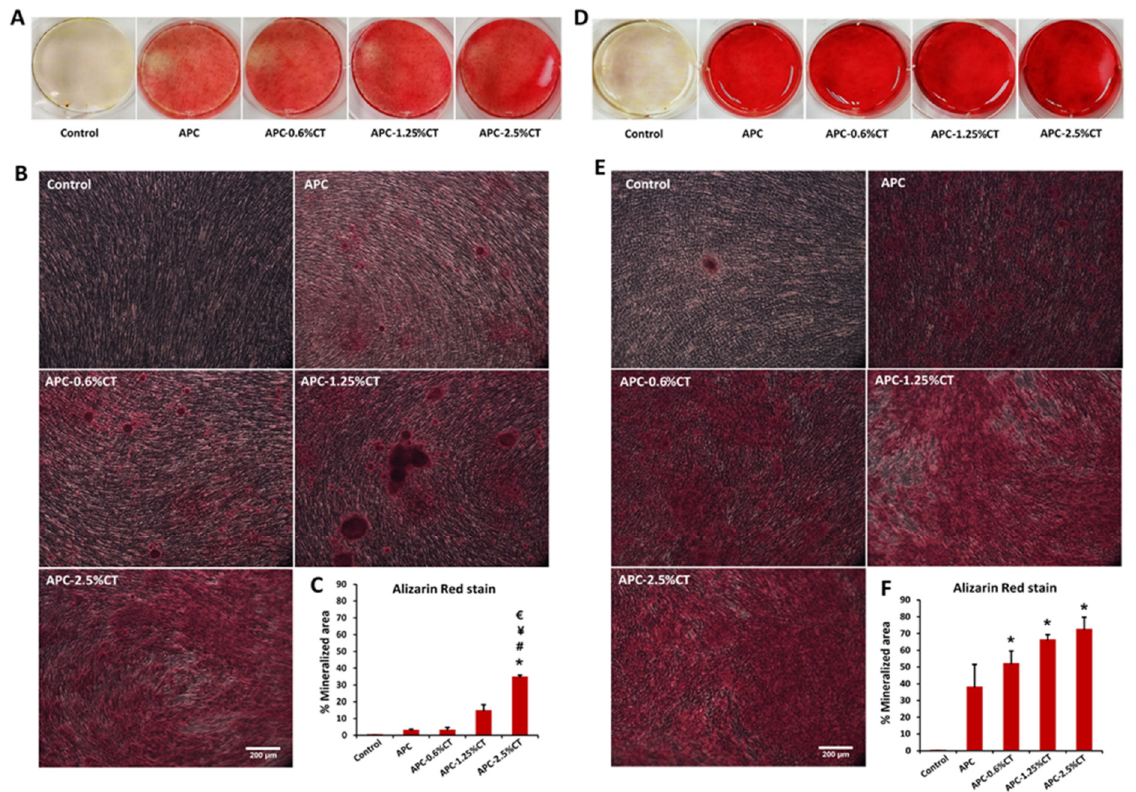
Figure 5. Representative images of calcium deposit formation after ( A , B ) 14 and ( D , E ) 21 days of SHED exposure to APC and APC-CT as evaluated by Alizarin Red staining. Magnification is 100 × . Scale bar = 200 µ m. ( C , F ) Quantitation of calcium deposition as measured by ImageJ software. The data are presented as mean ± SD after 14 and 21 days. * p < 0.05 vs. control, # p < 0.05 vs. APC, ¥ p < 0.05 vs. APC-0.6%CT and € p < 0.05 vs. APC-1.25%CT, ( n = 3).